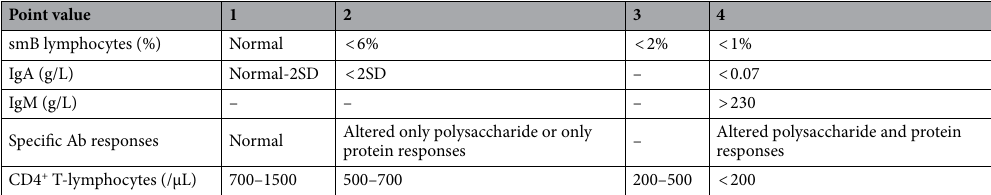
Table 1. VISUAL score of combined analytical biomarkers at diagnosis. The VISUAL score was designed based on combined immunological biomarkers at CVID diagnosis retrospectively to our cohort of CVID patients. Only those variables that proved to be statistically significant in the multivariable tests (ANOVA) for severity score were included. smB lymphocytes, IgA, specific Ab responses, CD4 + T-lymphocytes, and increase in serum IgM were scored from 1 to 4 according to the magnitude of the